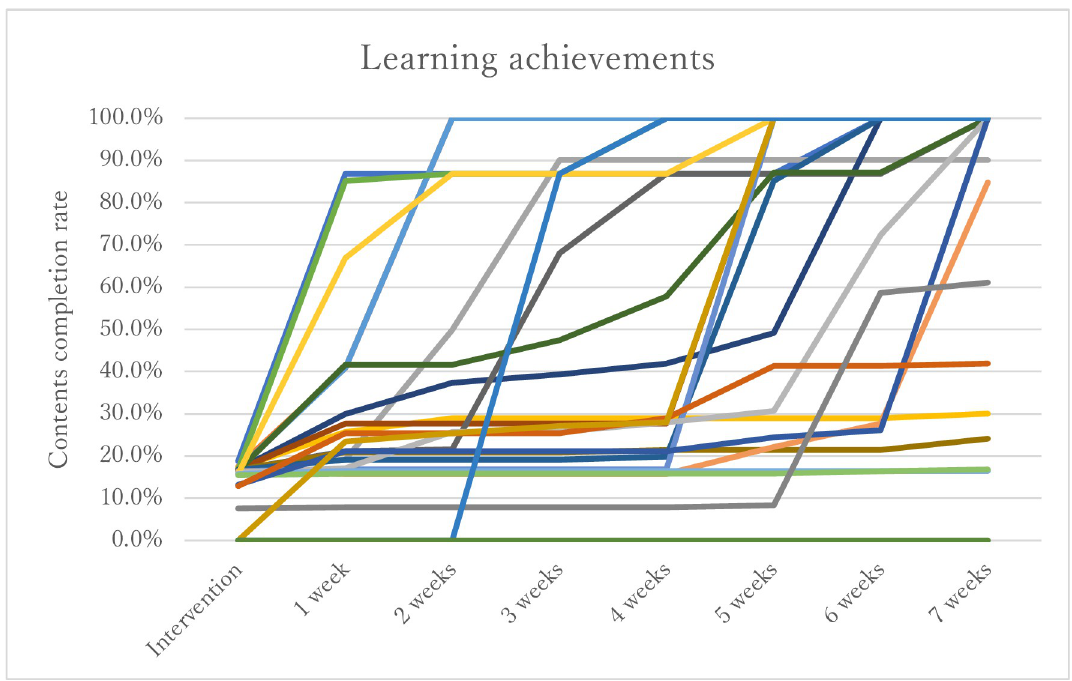
Fig 2. Learning achievements of midwives.